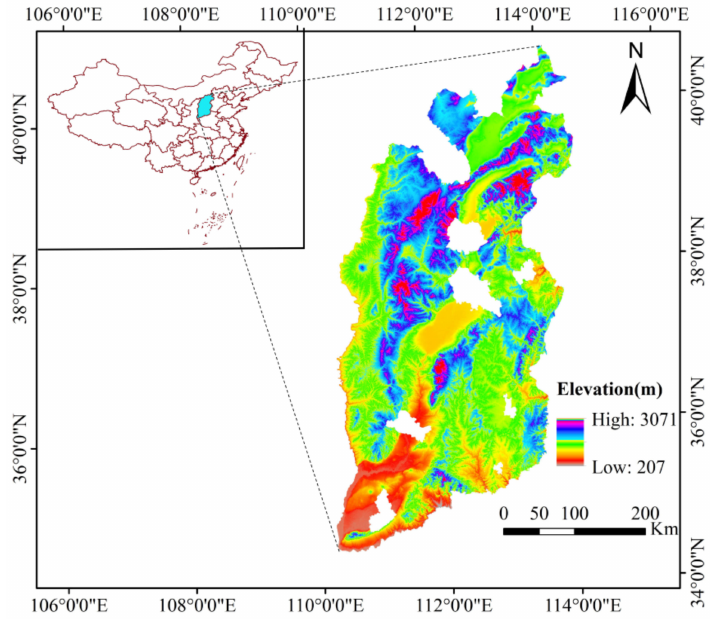
Figure 1. Location of the study area.